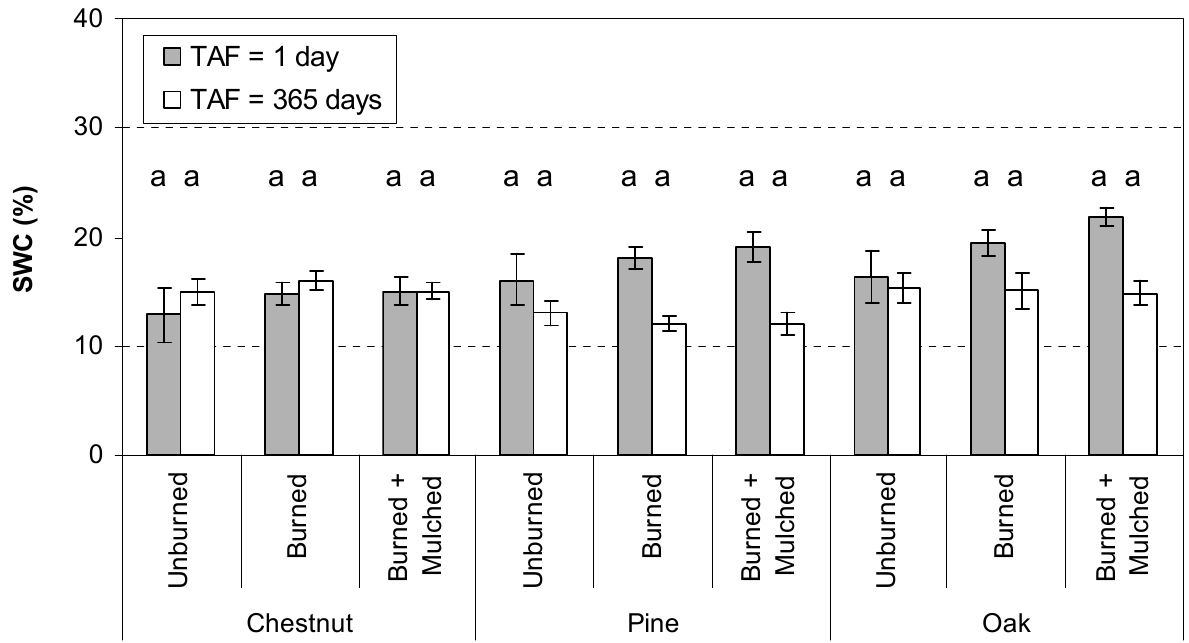
Figure 4. Soil water content (SWC) measured after prescribed fire and soil mulching with fern in the experimental site (Samo, Calabria, Southern Italy). Notes: bars report mean ± std. dev. (n = 3); TAF = time after fire. Different lowercase letters indicate significant differences in the interaction between soil conditions and time after fire, respectively, after Tukey’s test ( p < 0.05).